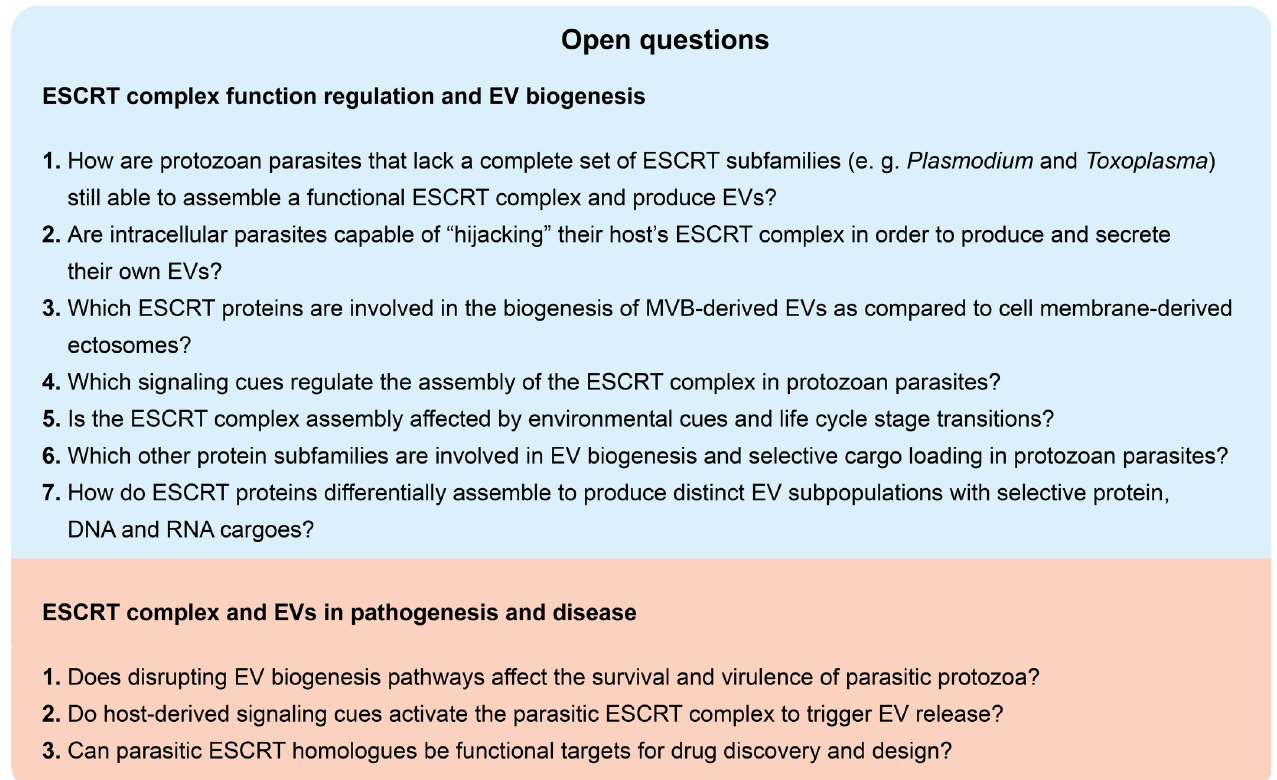
Fig 2. Open questions in EV biogenesis of parasitic protozoa. ESCRT AU : AnabbreviationlisthasbeencompiledforthoseusedinFig 2 : Pleaseverifythatallentriesarecorrect : , Endosomal Sorting Complex Required for Transport; EV, extracellular vesicle; MVB, multivesicular body.